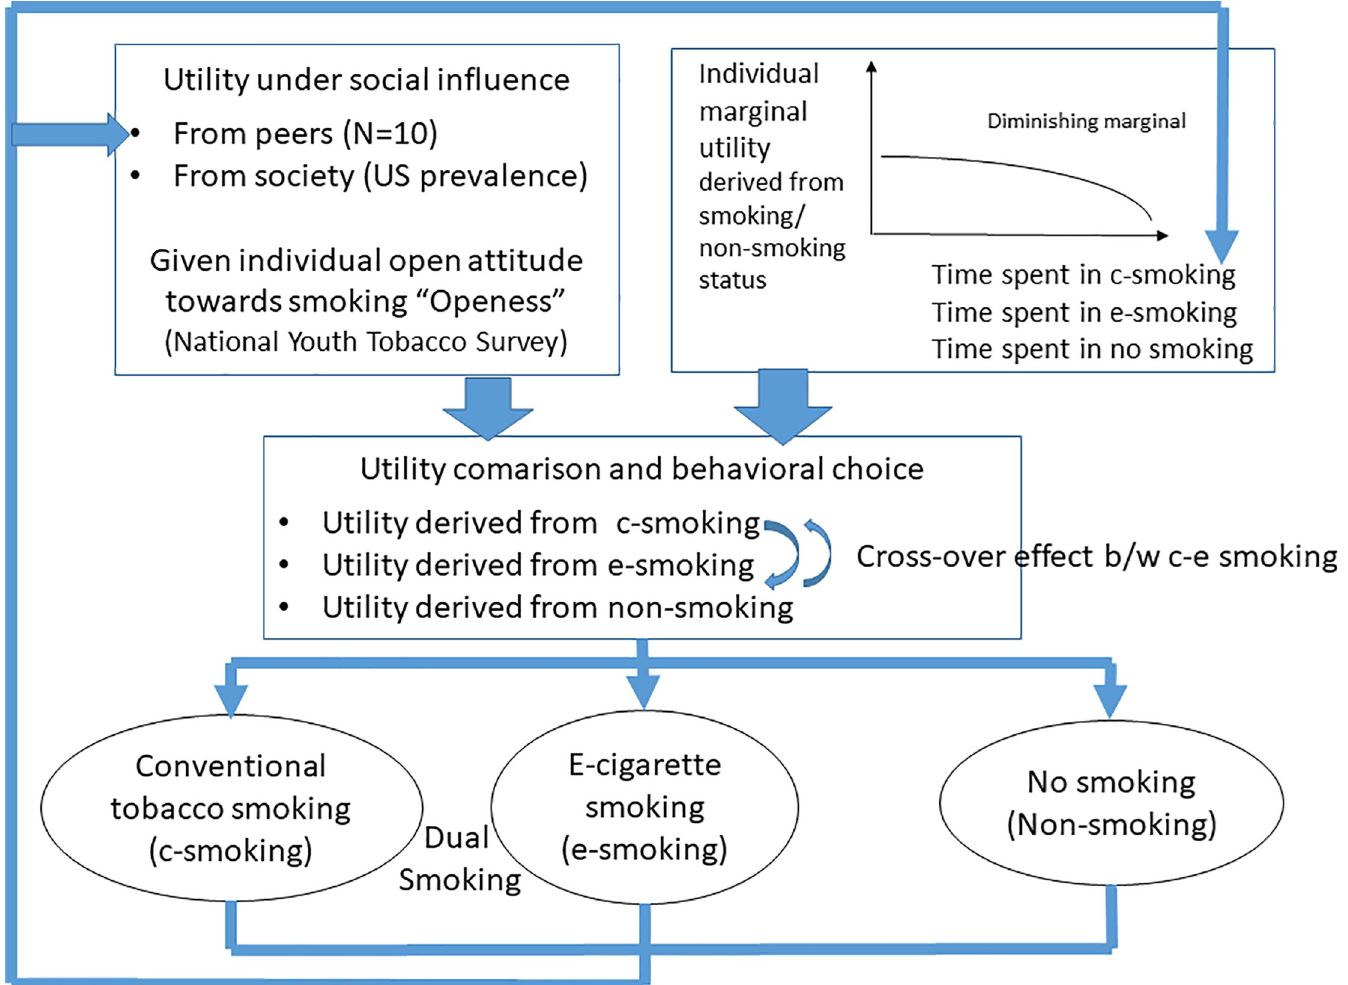
Fig 1. Model description. Cycle of behavioural choice for smoking status and types of smoking.